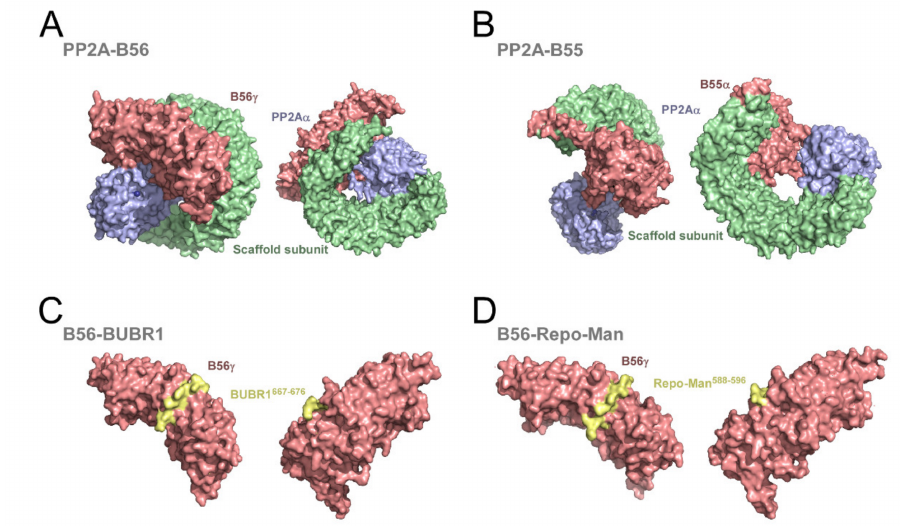
Figure 2. Structure of PP2A α holoenzymes. ( A , B ) Surface representation of the three-dimensional structure of the PP2A α catalytic subunit (light blue) in complex with the scaffold subunit and the regulatory subunits, B56 γ ( A ) or B55 α ( B ). The PP2A catalytic subunit is represented in light blue with manganese atoms in the active site represented as dark blue spheres. The scaffold subunit is represented in green and the regulatory subunits are depicted in light red. Protein Data Bank (PDB) accession ID 2NPP ( A ) and 3DW8 ( B ). ( C , D ) Surface representation of the three-dimensional structure of B56 γ (light red) interacting with BUBR1 667–676 and Repo-Man 588–596 peptides (yellow). Both peptides encompass a LxxIxE motif that binds to a conserved basic pocket at the concave surface of B56 γ . PDB accession ID 5K6S ( C ) and 5SW9 ( D